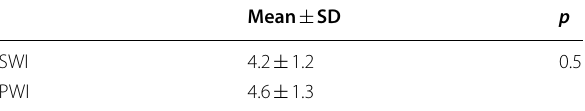
Table 4 SWI changes versus PWI changes